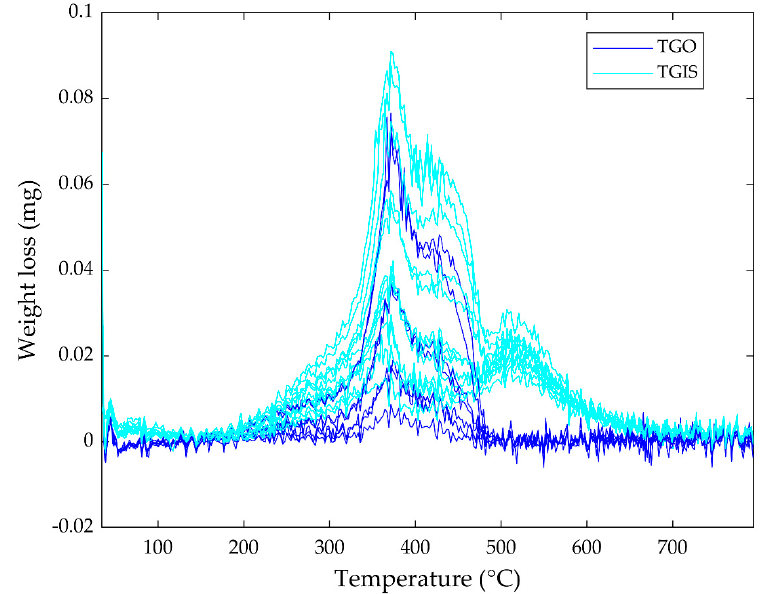
Figure 2. Weight loss (mg) of all 20 samples during heating in the Simultaneous Thermal Analysis (STA) instrument. TGO = Tire granules only, TGIS = Tire granules in formulated sediment.